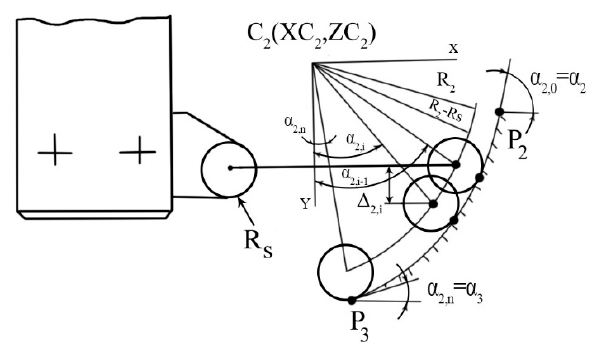
Figure 5. The points outlined, the centers corresponding to the connection point at the tip of the